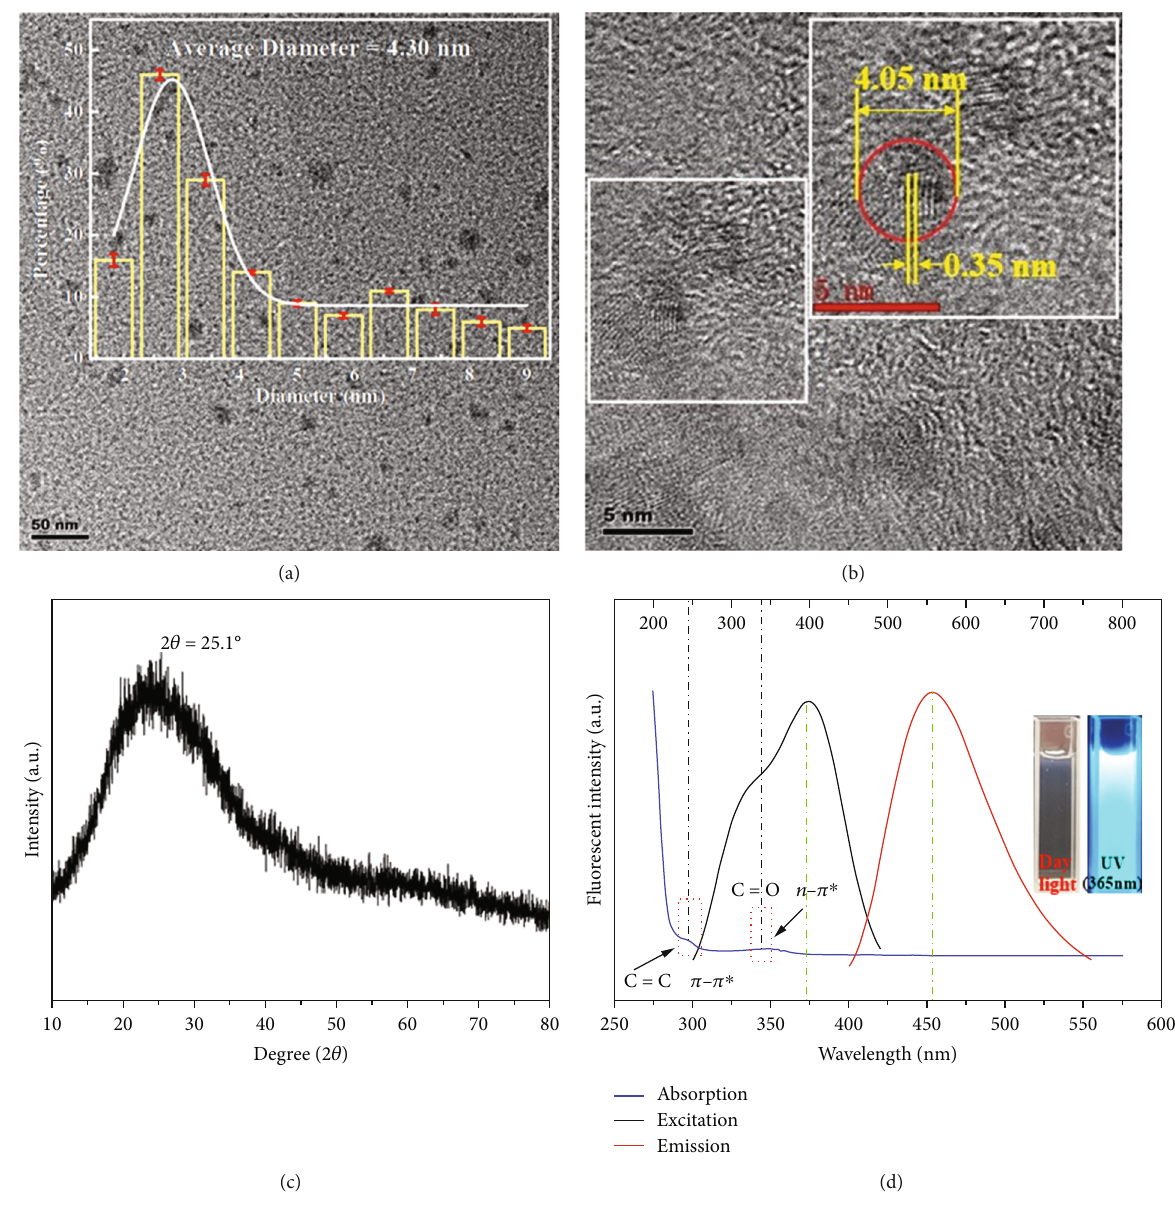
Figure 2: (a) TEM image and particle size distribution of the CQDs, (b) high-resolution TEM image of the CQDs, (c) XRD pattern of the CQDs, (d) UV/Vis absorption and fl uorescence excitation and emission spectra of the CQDs in aqueous solution. (The inset is a photo of the CQDs solution under sunlight and UV